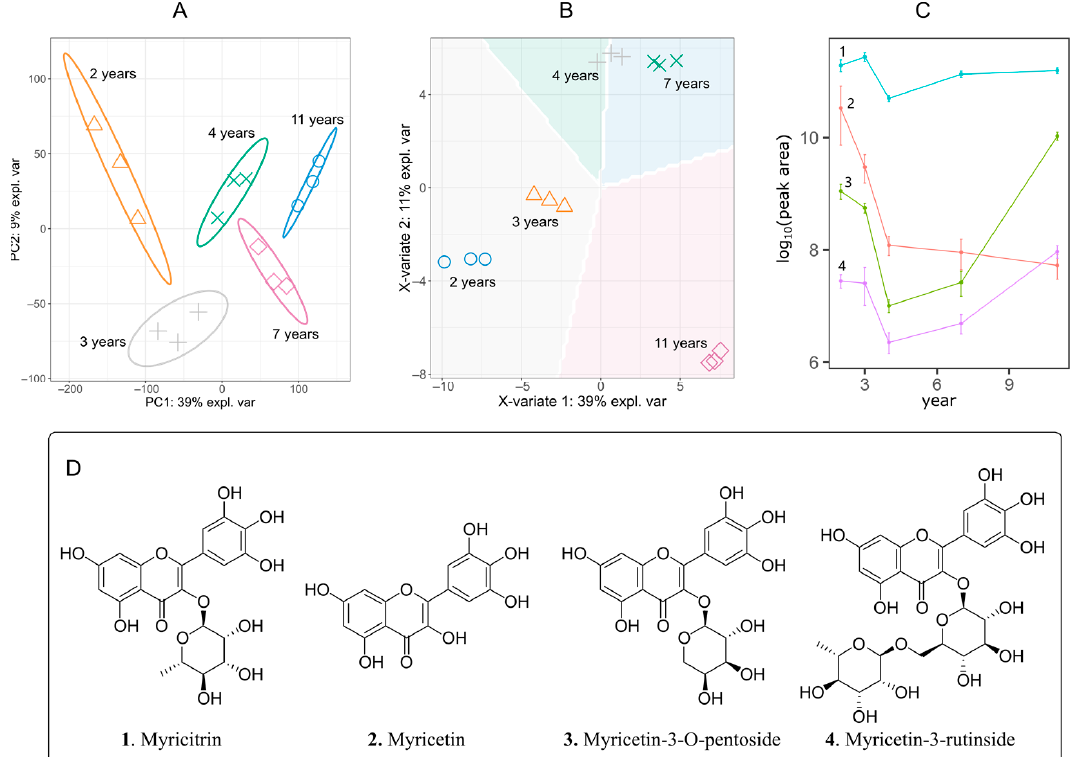
Figure 3. LC-MS/MS features of leaves from different years old trees ( A. truncatum ). ( A ) PCA analysis; ( B ) sPLS-DA analysis with multivariate prediction. ( C ) Content change trend of myricitrin-like components. 1-myricitrin; 2-myricetin; 3-myricetin-3- O -pentoside; 4-myricetin-3-rutinoside. Peak areas were calibrated with an external standard myricitrin. ( D ) Chemical structures of myricitrin-like components.